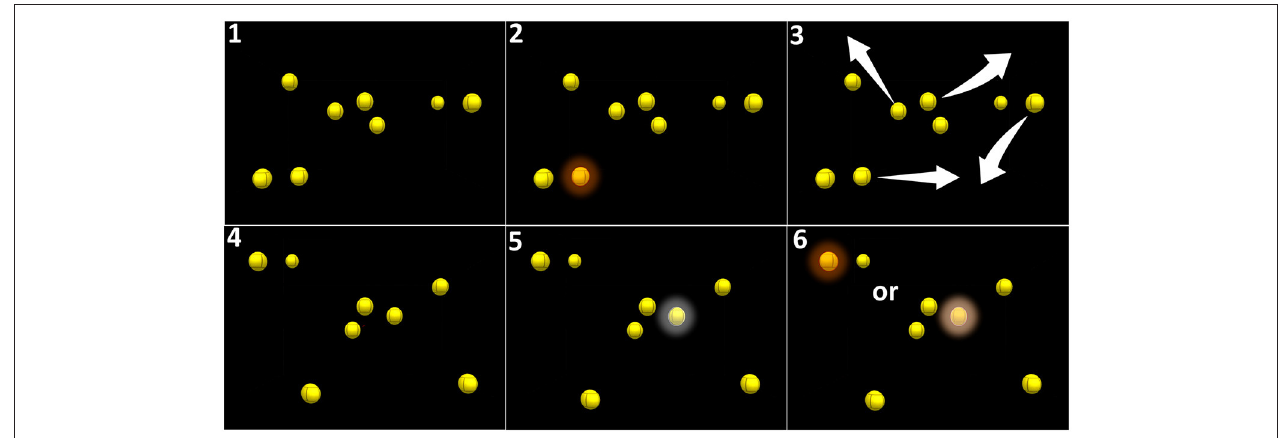
FIGURE 2 | Principle of audiovisual stimulation program (NeurofyResearch). Sequence of the visual task. (1) Eight yellow still spheres are present in a virtual cube. (2) One of these spheres turns red for 5s (cued target) and returns to yellow. (3) All spheres randomly move following linear paths across the visual field encompassing the blind field and bouncing on one another and on the walls of the virtual 3D cube when collisions occurred. (4) After 30s, the spheres stopped moving. (5) The patient had to select the cued target using a hand-guided virtual laser pointer. (6) A correct selection is considered a positive